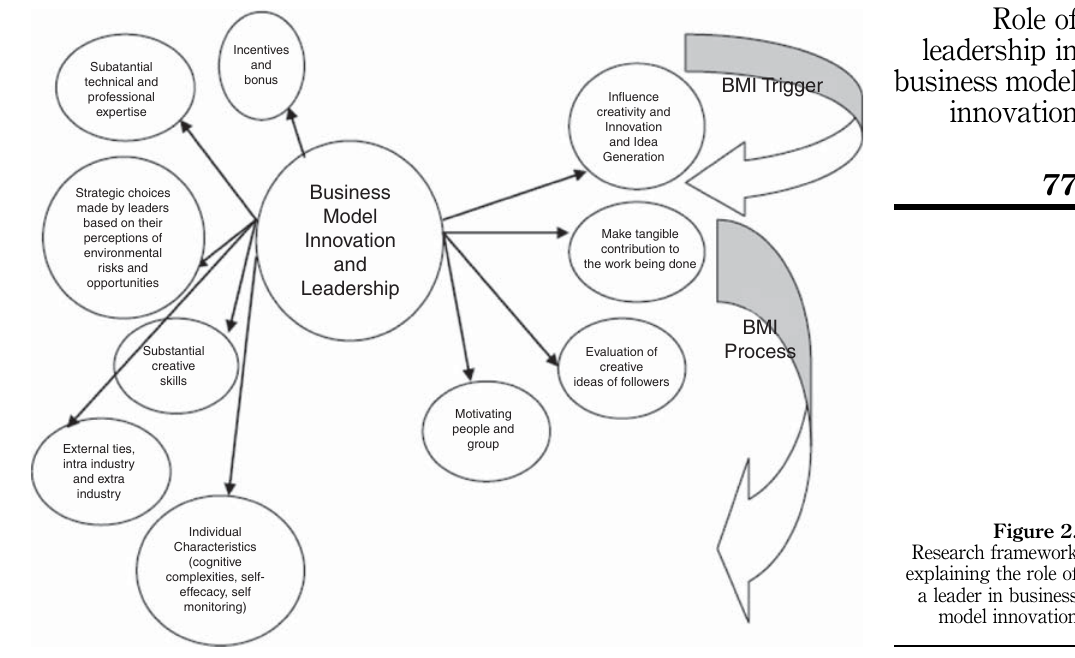
Figure 2. Research